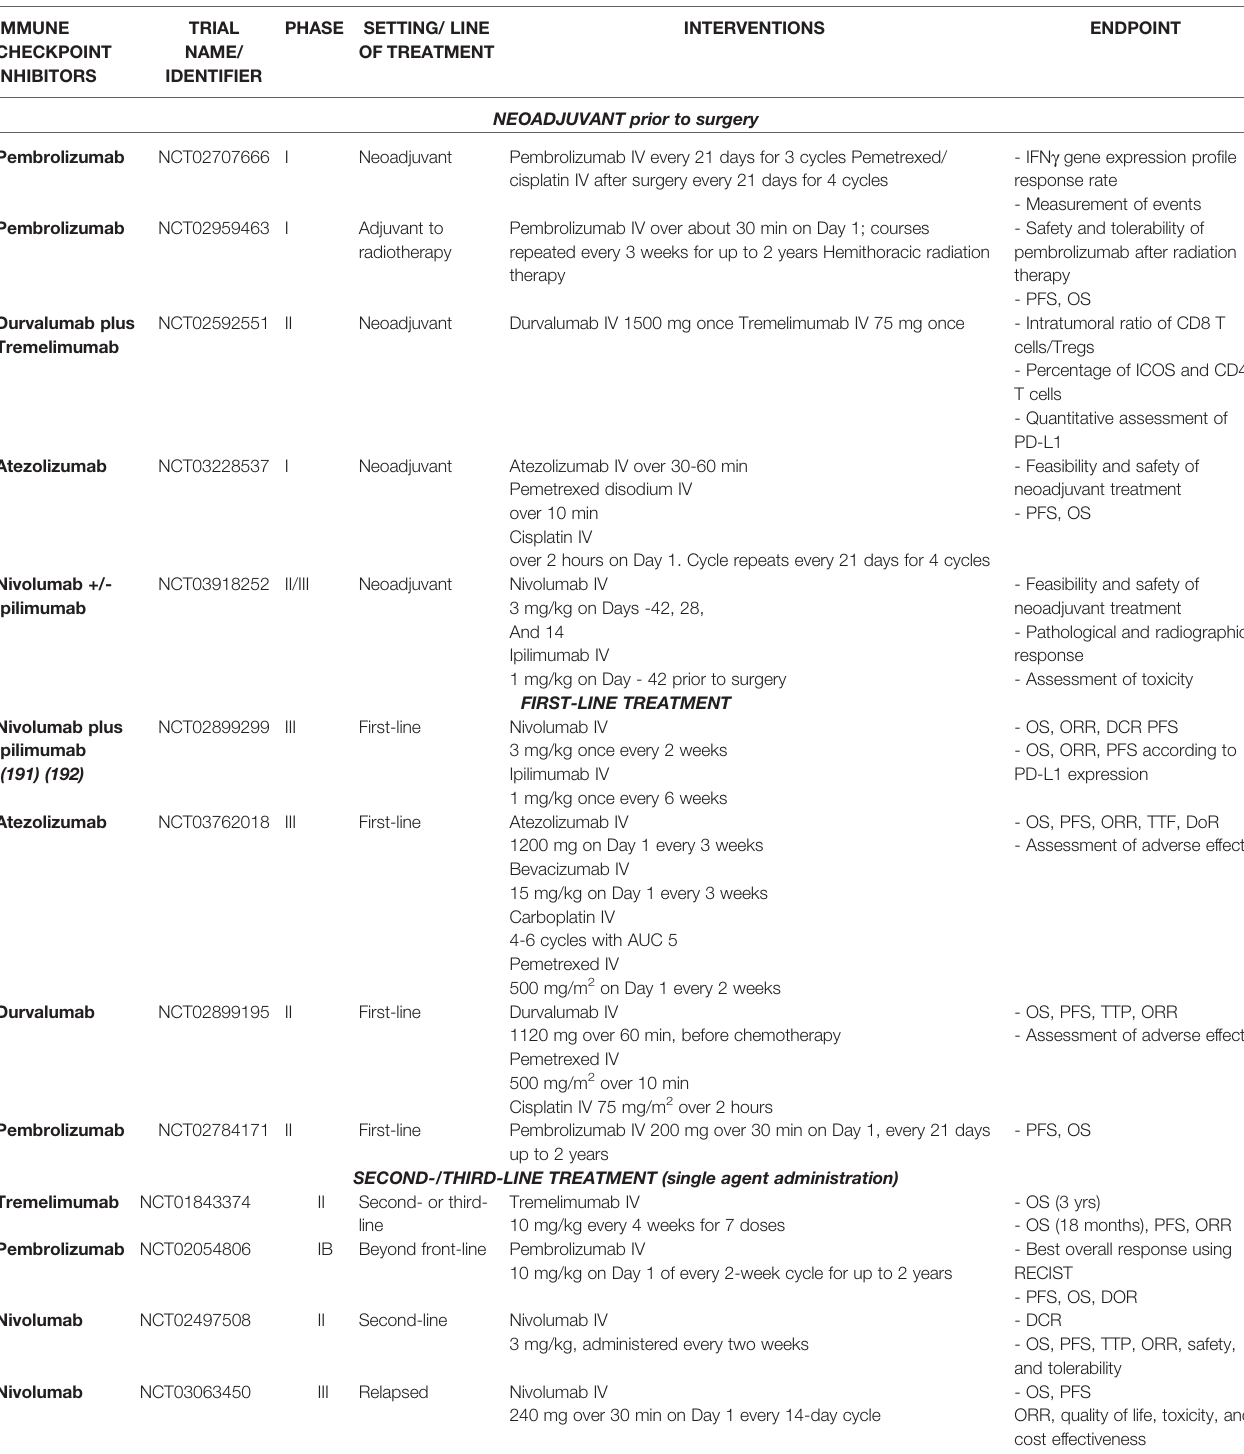
TABLE 1 | Clinical trials using immune checkpoint inhibitors. IMMUNE